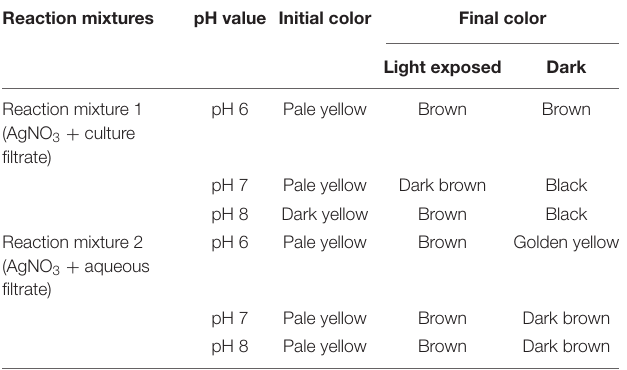
TABLE 1 | Biosynthesis of silver nanoparticle (AgNP) initial and final color of the reaction mixtures. Reaction mixtures